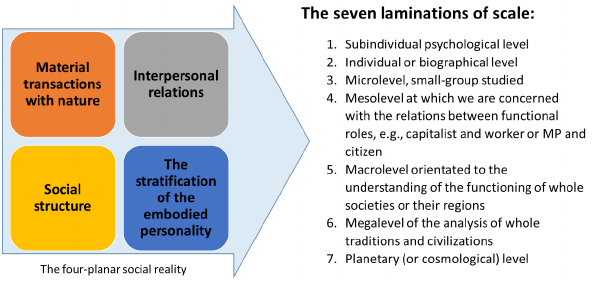
Fig. 1 . Ontological stand of dialectical critical realism. Adopted from (Bhaskar et al.